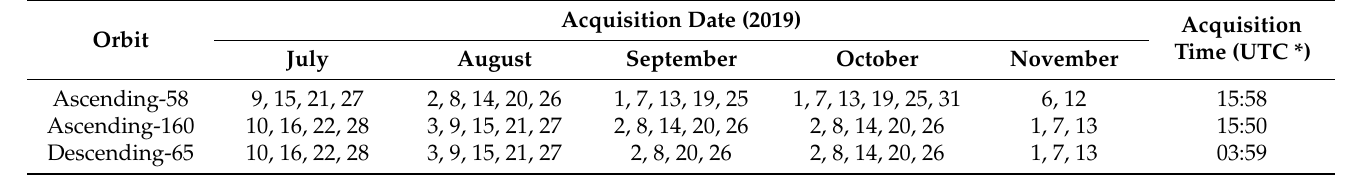
Table 2. Acquisition dates of Sentinel-1 satellite images used in the study.